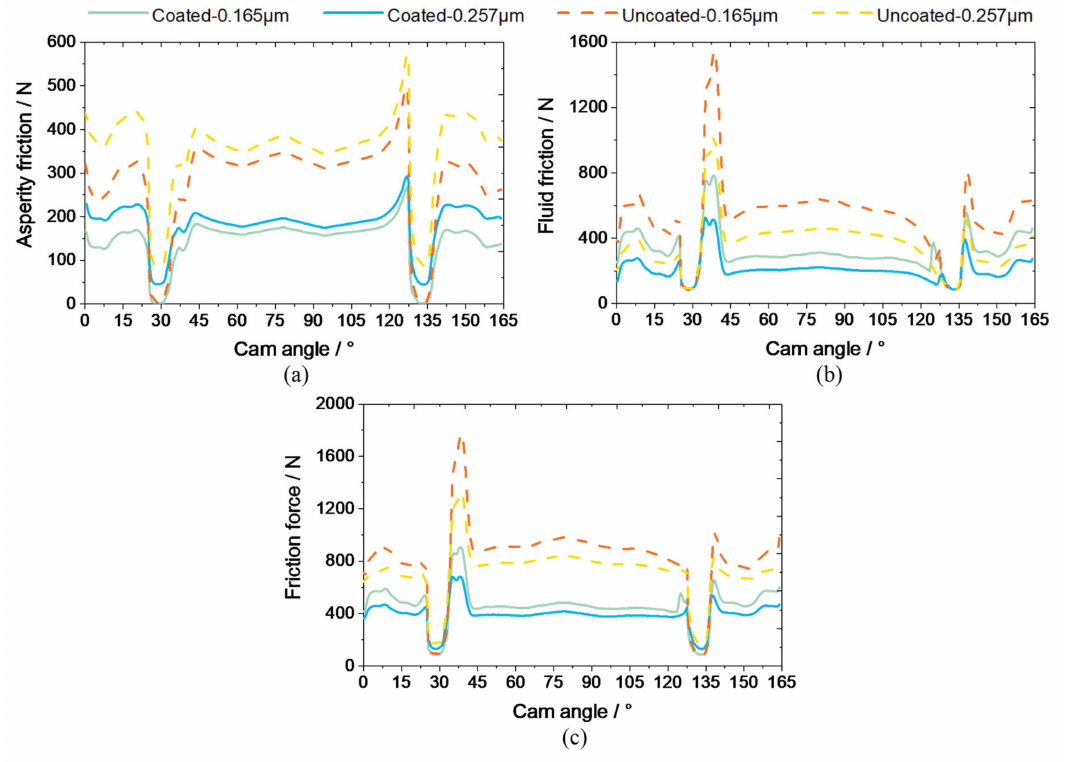
Figure 12. Frictional variations during a cam cycle under the heavy load: ( a ) asperity contact friction, ( b ) fluid friction, and ( c ) total friction.